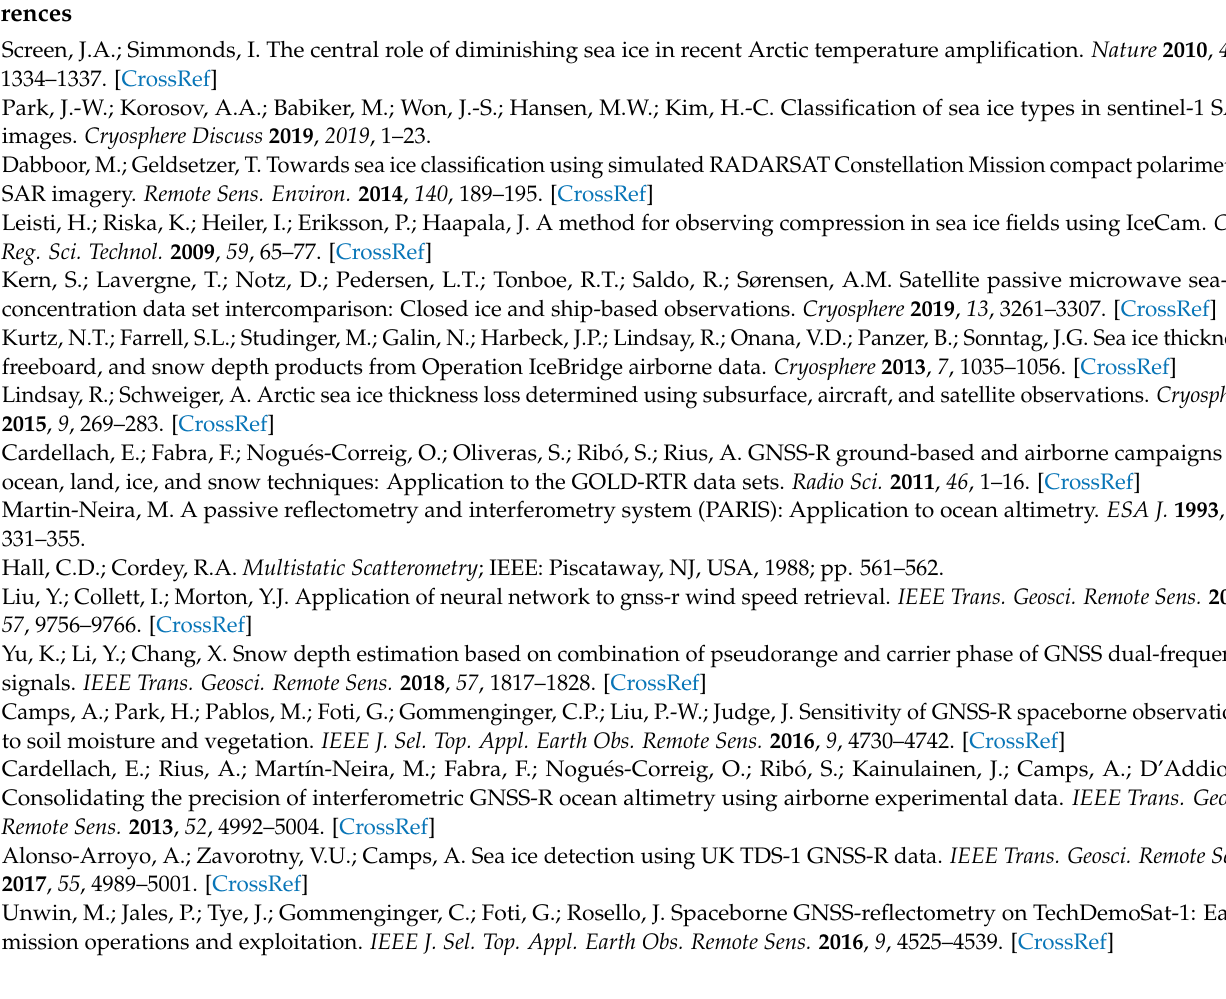
March, ( c ) April, and ( d ) November are used as the test set in turn.